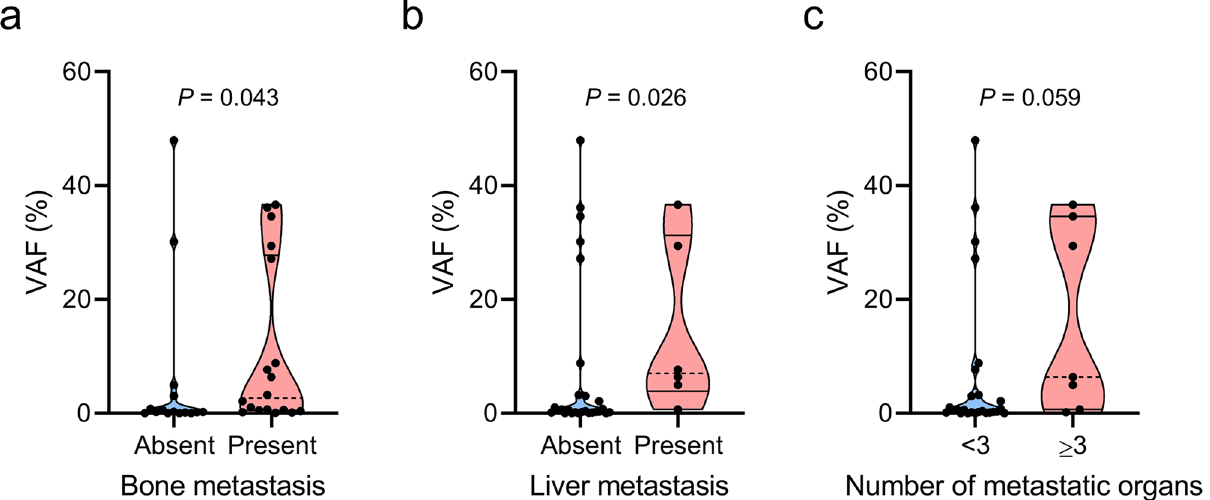
Figure 1. EGFR L858R variant allele fractions (VAFs) according to metastatic factors. Violin plot with dot plot depicting EGFR L858R VAF levels according to the presence of bone metastasis ( a ), the presence of liver metastasis ( b ), and the number of metastatic organs ( c ). Dashed line and solid line indicate the median and interquartile range, respectively.